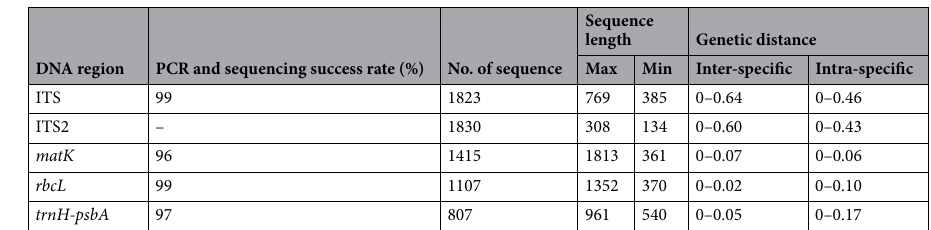
Table 2. Sequence characteristics of different DNA markers evaluated in this study.